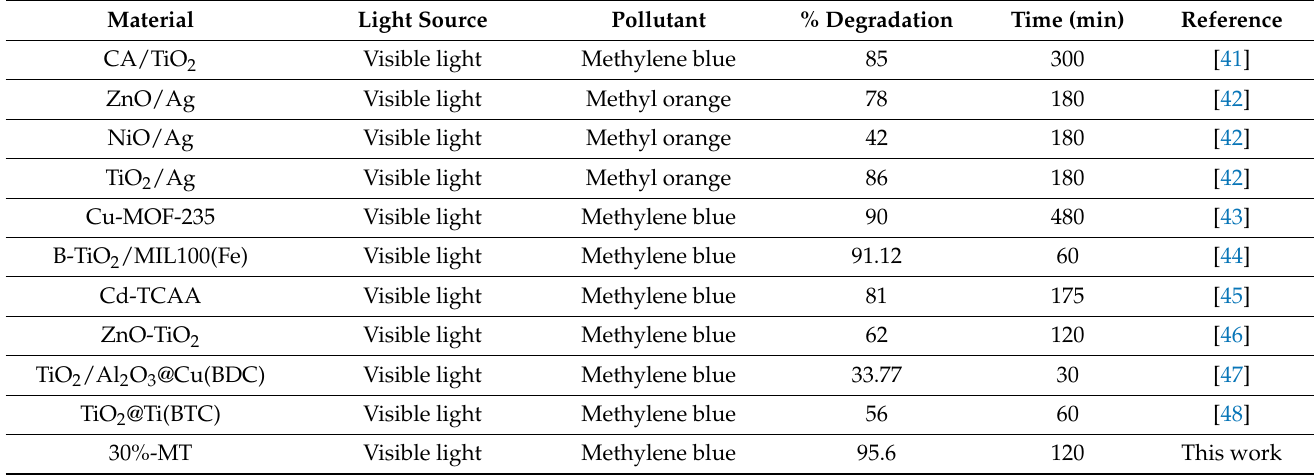
Table 2. Comparison of the percentage of degradation of 30%-MT with previously reported